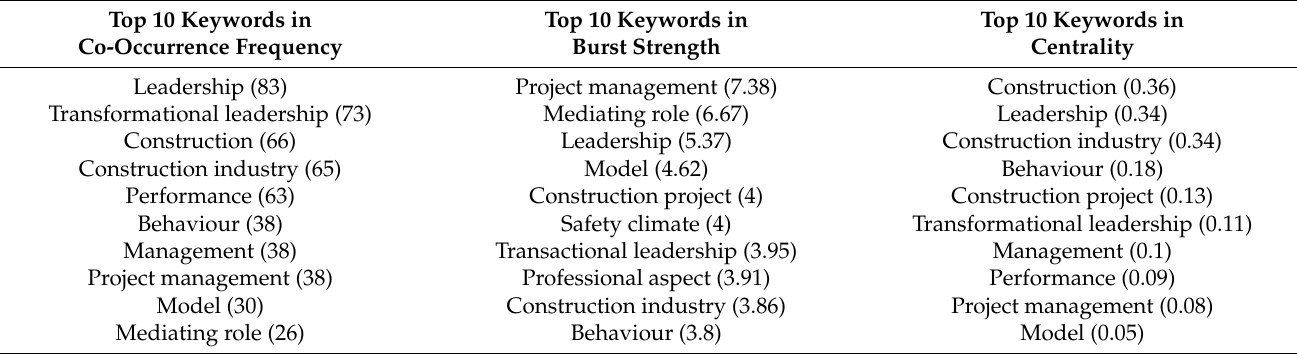
Table 7. Top 10 keywords in terms of co-occurrence frequency, burst strength and